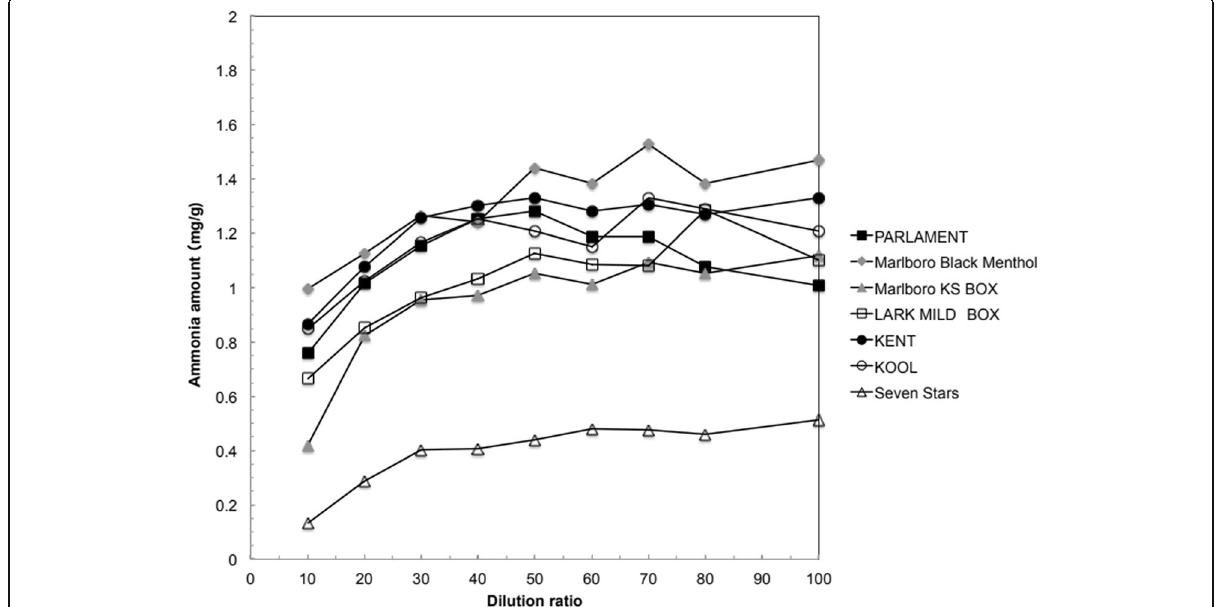
Fig. 1 Effects of dilution on ammonia determination with an ammonia test